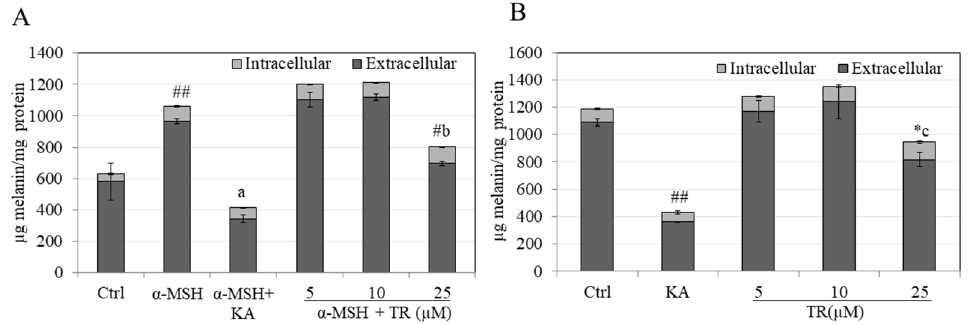
Figure 2. Total melanin levels (Intracellular and Extracellular) in cultures of B16F10 mouse melanoma cells maintained for 72 h in the presence of different concentrations of TR in ( A) α -MSH-stimulated melanogenesis; ## p < 0.001 vs. Ctrl; letter a - p < 0.001 vs. α -MSH; # p < 0.01 vs. α -MSH; letter b - p < 0.001 vs. TR (10 µM) and; ( B ) Basal melanogenesis; KA was used as a positive control at 200 µM; ## p < 0.001 vs. Ctrl, * p < 0.05 vs. Ctrl; letter c - p < 0.001 vs. TR (10 µM); One-way ANOVA with Tukey’s test; The results reported are from at least two independent experiments; the Mean ± SD shown are from triplicate wells from a representative experiment; # p < 0.01 vs. α -MSH.